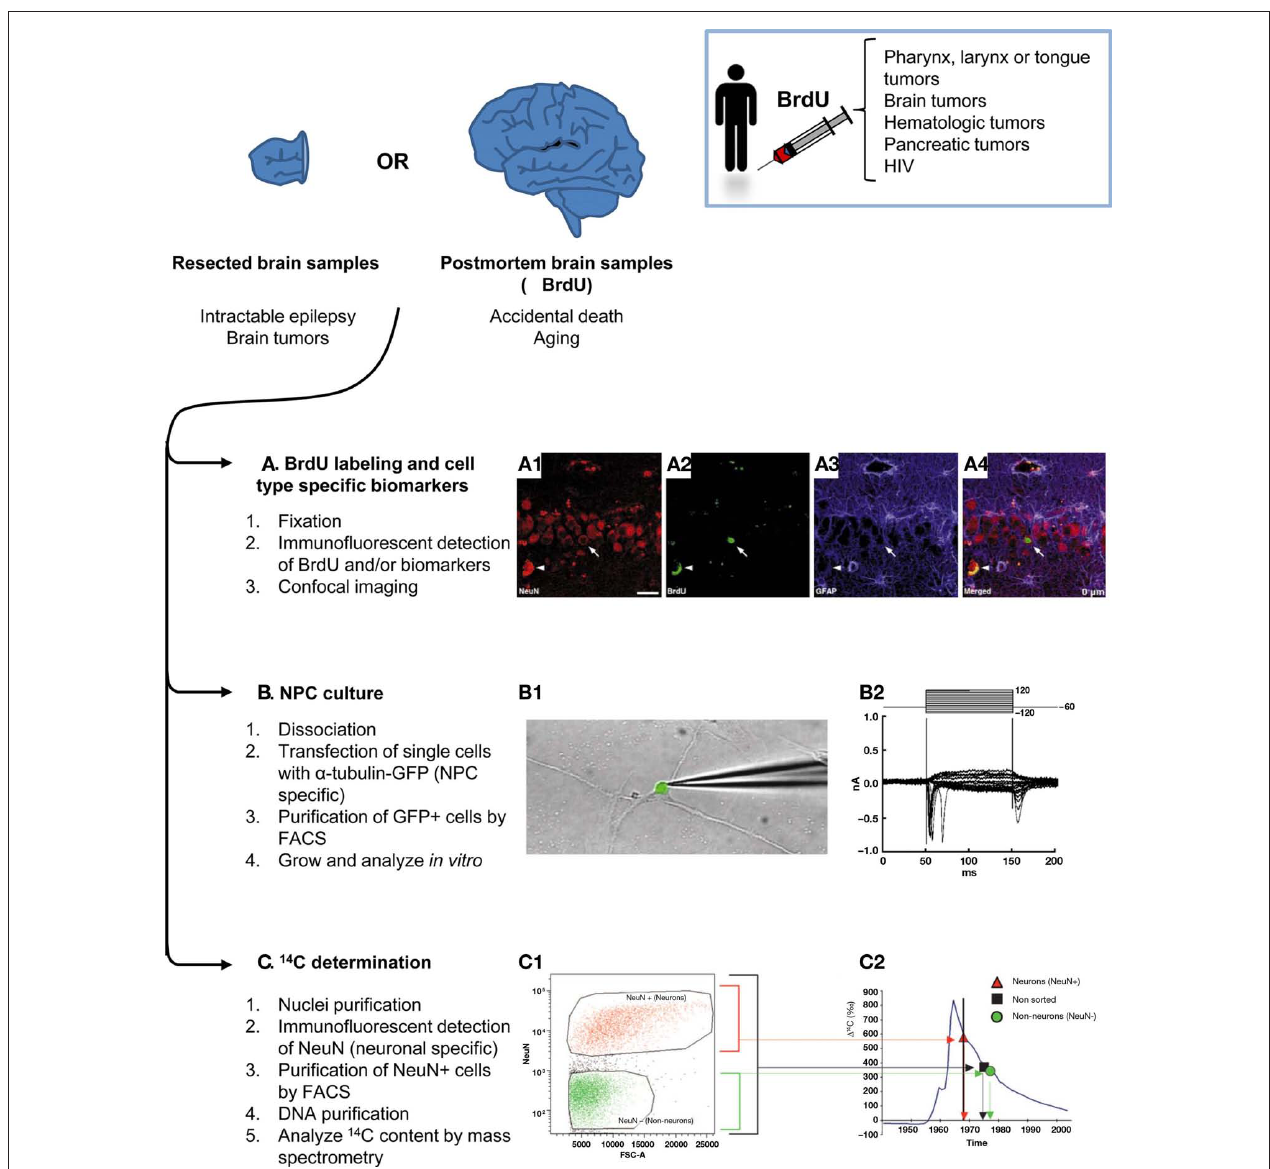
FigUre 2 | Methods to assess adult human neurogenesis in resected or postmortem brain samples. Brain samples from live individuals can be obtained by surgical resection of the focus of the seizures in intractable epilepsy or brain tumors. Alternatively, bank tissues store frozen or fixed brain samples from accidental deaths and aging individuals, some of which may have been treated with BrdU. Once the tissue is obtained, three main methods can be applied to study neurogenesis: (A) Immunodetection of BrdU and/or proliferation and cell-type specific biomarkers in fixed tissue, followed by analysis by confocal analysis. An example of new born neurons in the SGZ of the hippocampus of an aging patient is shown in (A1) NeuN + neurons (red), (A2) BrdU labeling (green), (A3) GFAP + astrocytes (blue), (A4) merged image showing one newborn neuron labeled with BrdU and NeuN, but not with GFAP (arrow); and non-specific fluorescence emission due to lipofuscin accumulation in old tissue (arrowhead). Scale bar is 25 μm. (B) Culture of NPCs. In this case, the fresh tissue is dissociated and transfected with a reporter gene (GFP) driven by a T α 1 tubulin promoter, an early neuronal regulatory gene. The transfected cells are then purified by FACS and cultured in vitro . The grown cells differentiate into fully functional neurons which when patch-clamped in a voltage-clamped configuration (B1) show typical depolarizations of the voltage-